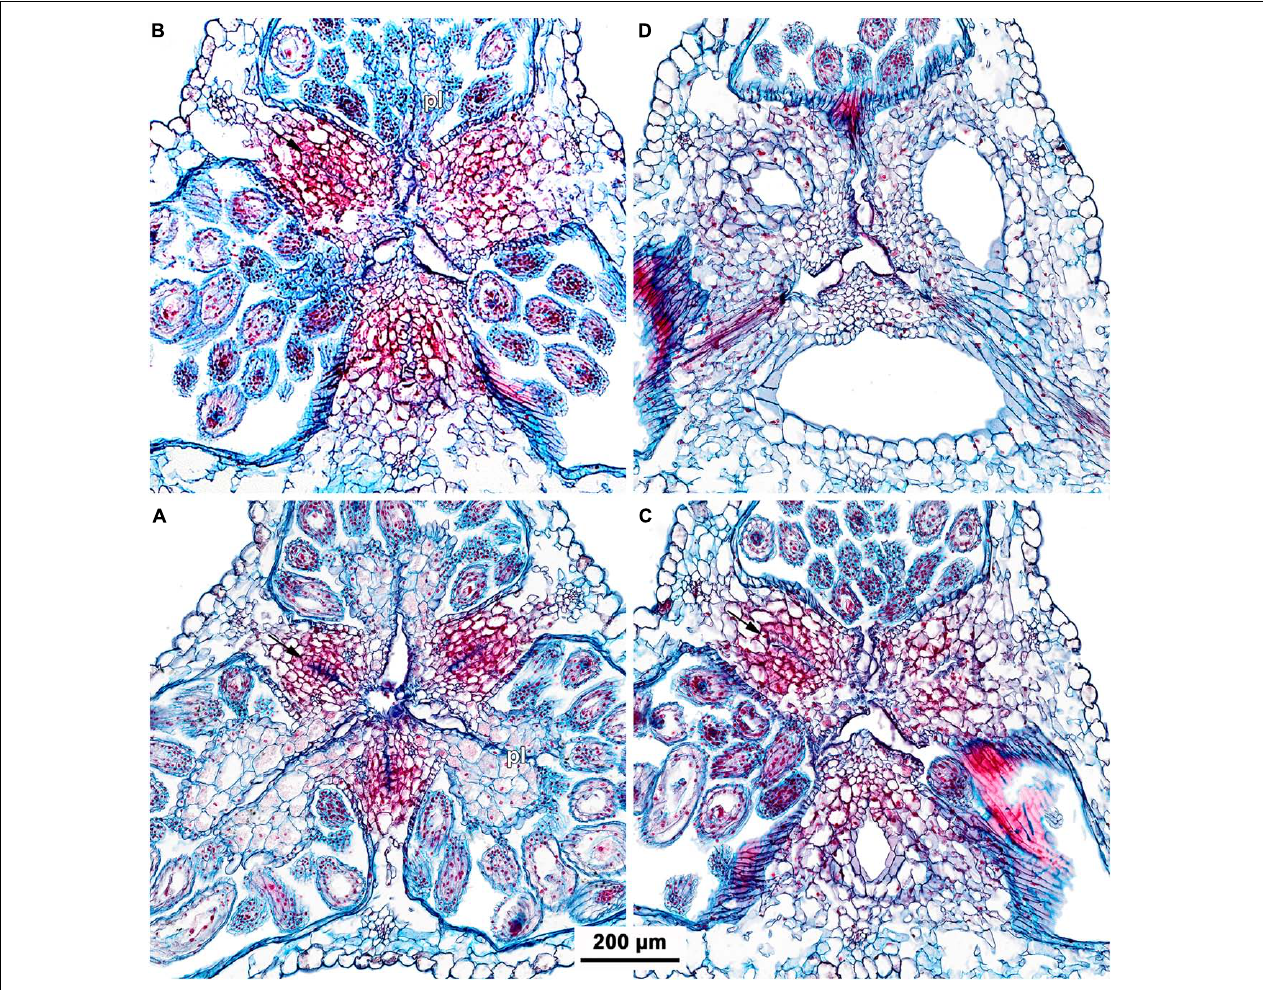
FIGURE 6 | (A–D) Ascending series of transverse microtome sections of flower bud of Burmannia coelestis ( Nuraliev et al. 2736 ) showing structure of septal nectaries (LM). Arrow indicates septal nectary. pl,